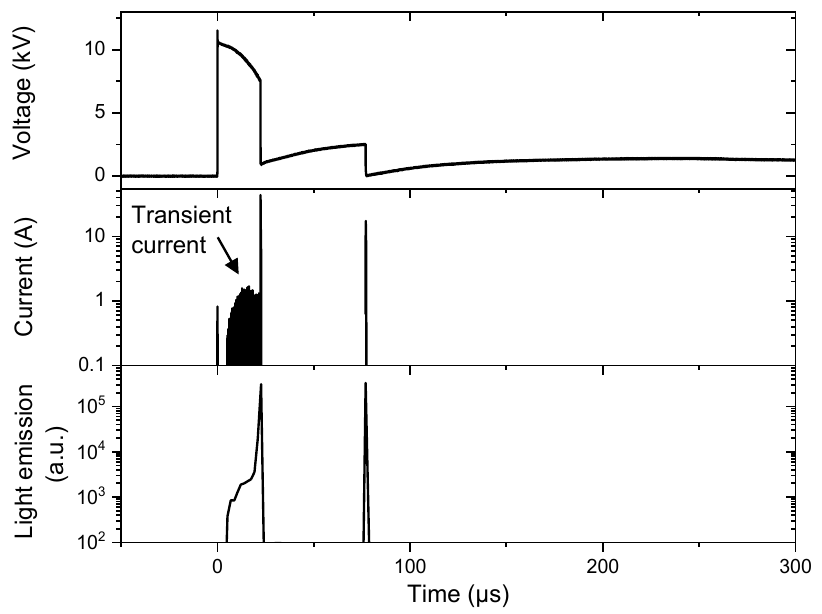
Figure 2. Electrical signals and total emission measured during one single experiment (U = 12 kV, σ = 100 µS/cm, gap = 2 mm).